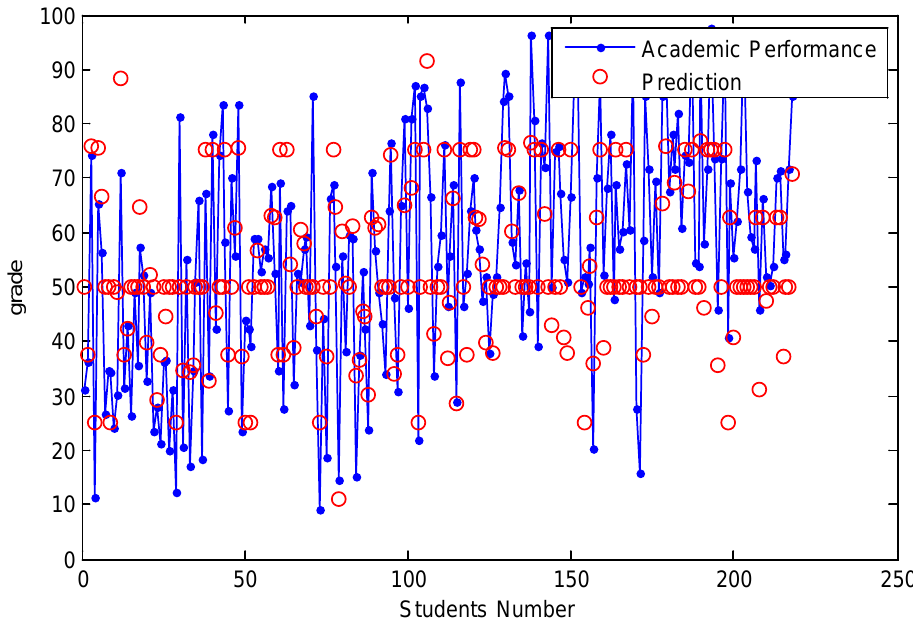
Graph 1. A comparison for academic performance and